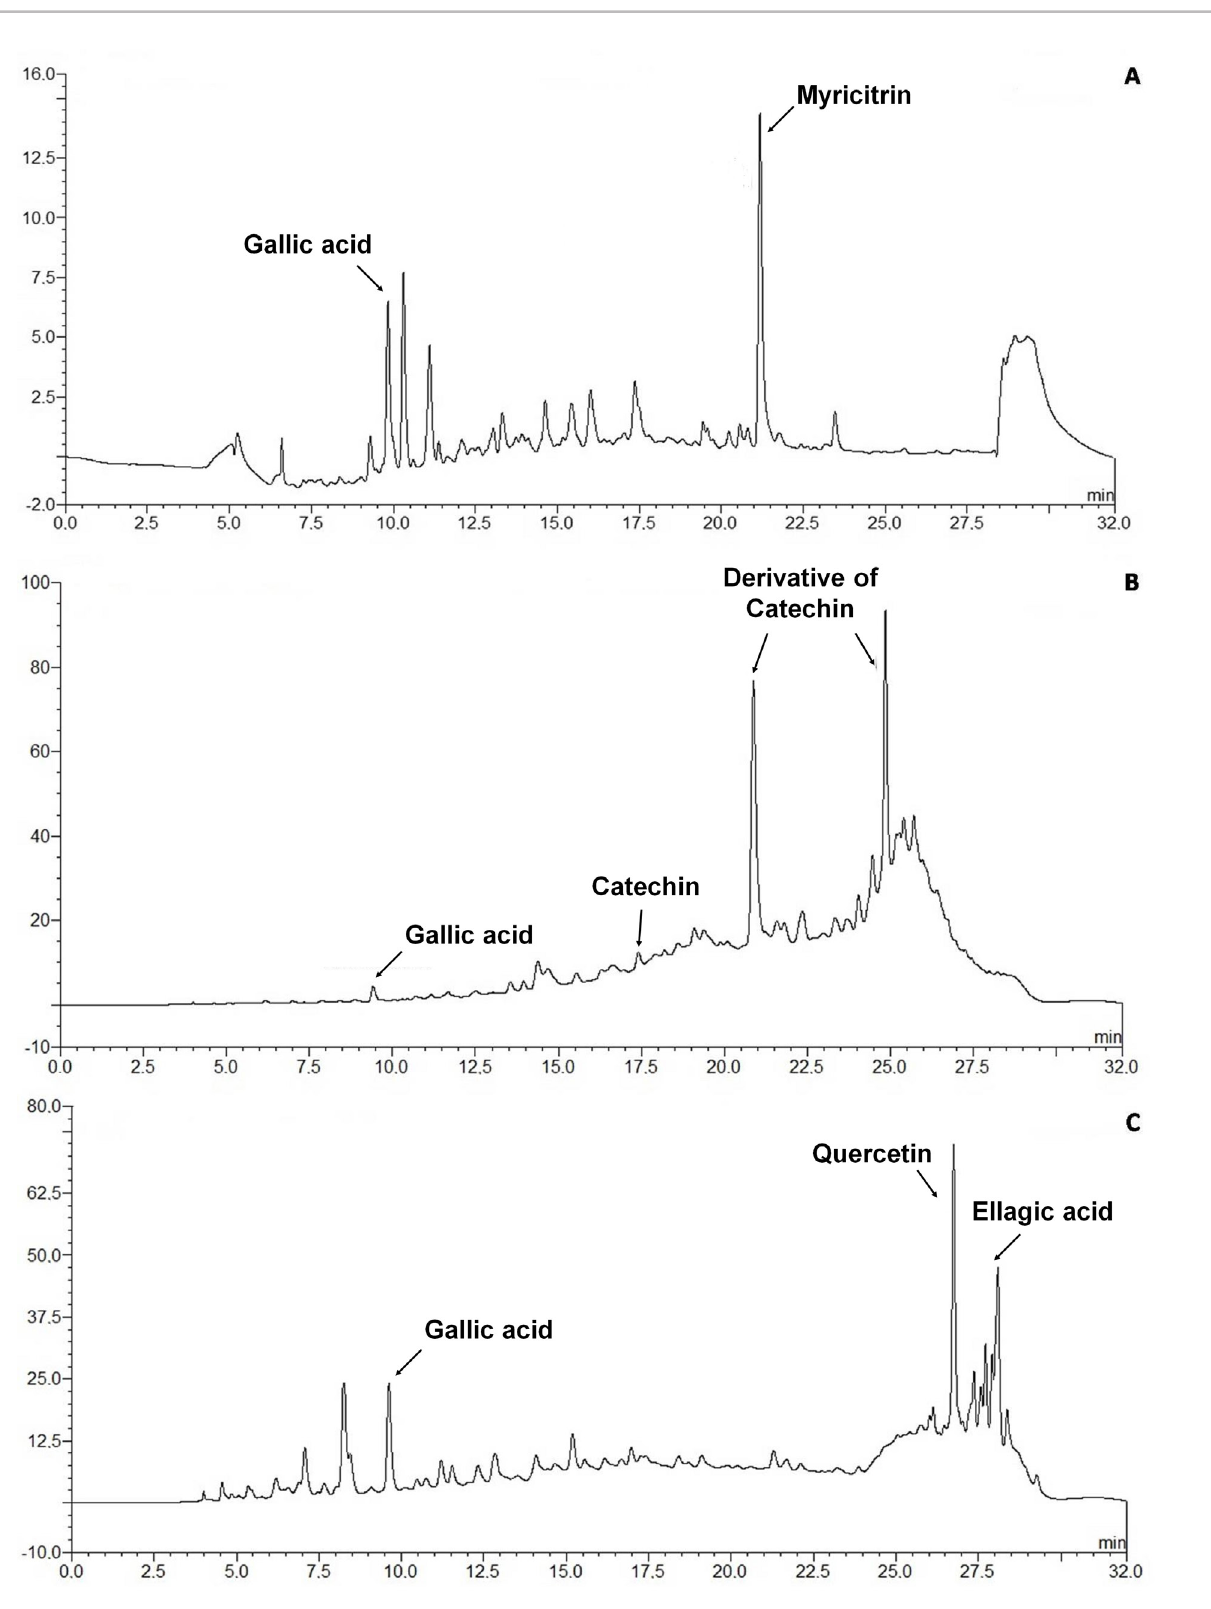
FIGURE 1 - Chromatographic fingerprints obtained by HPLC of crude extracts (acetone-water) from E. uniflora (A), L. ferrea (B) and P. guajava